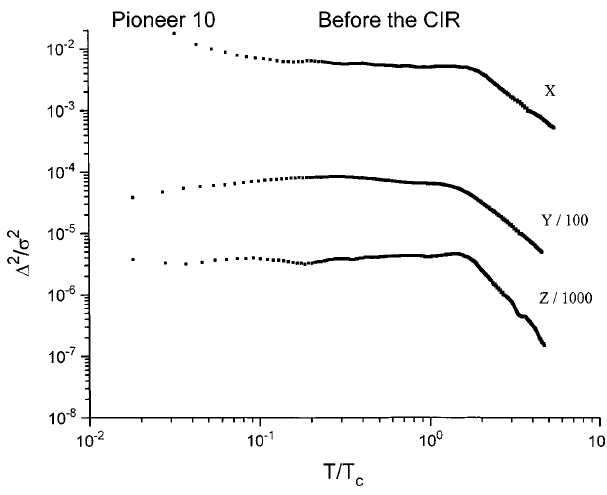
Fig. 6. The variance of the means D 2 (cid:137) B (cid:138) y and z field components of data taken on day 292, ‘‘before the CIR’’, calculated for intervals T and plotted as functions of T corresponding correlation